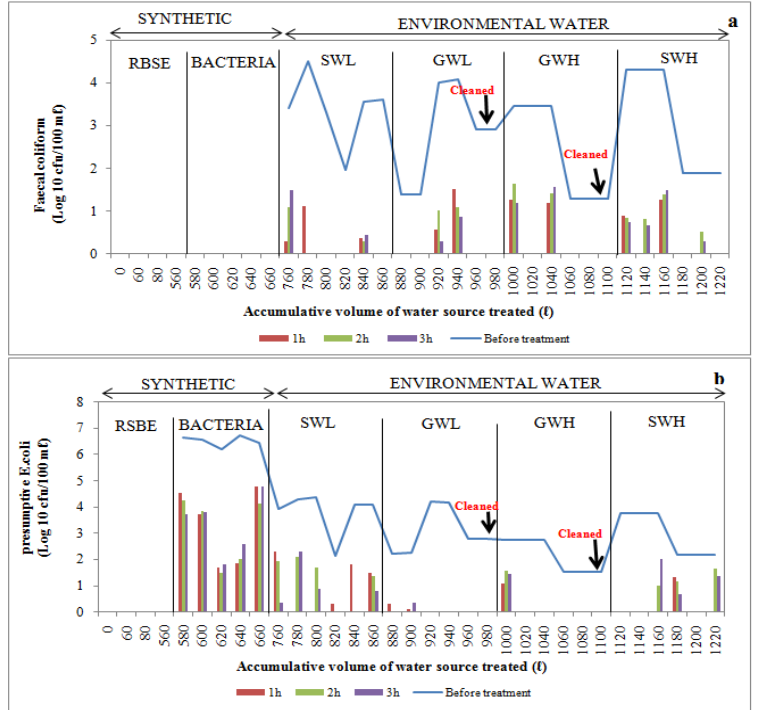
Figure 12. Log faecal coliform ( a ) and E.coli ( b ) concentrations in ceramic candle filter 10 before and after treatment of over 1220 L of source water, namely synthetic water and environmental water samples (SWL, GWL, GWH and SWH). RSBE is the running of the system before the experiment, using deionised water.